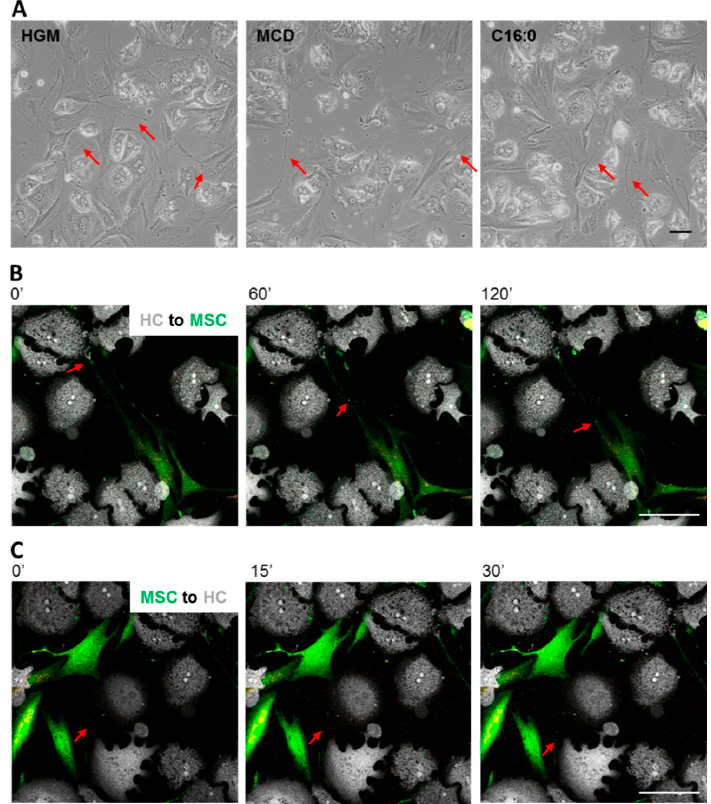
Figure 5. TNT-mediated cargo exchange between HCs and MSCs. ( A ) On day 1 of co-culture, the TNT structures (red arrows) derived from MSCs were readily detectable by phase contrast microscopy in cultures grown under all tested conditions. Scale bar 100 μ m. Corresponding movies may be opened in Supplementary Material file 3; ( B ) The delivery of cargos from HCs to MSCs and ( C ) from MSCs to HCs was monitored by co-culture of HCs and MSCs pre-labeled with CellTrace™ Yellow and MitoTracker™ Deep Red FM (pseudo-colored green and red, respectively). The whole culture was stained with CellTrace™ CFSE (pseudo-colored white) and the pictures were captured using time-lapse confocal imaging. When the first picture was taken, this time point was designated as time 0, to which the other time points refer. The direction of movement of cargos in the TNTs is indicated by the red arrows. Scale bar 100 μ m. Higher magnification images are available in Supplementary Material file 2, Figure S6 A–C. Corresponding movies may be opened in Supplementary Material file 4.